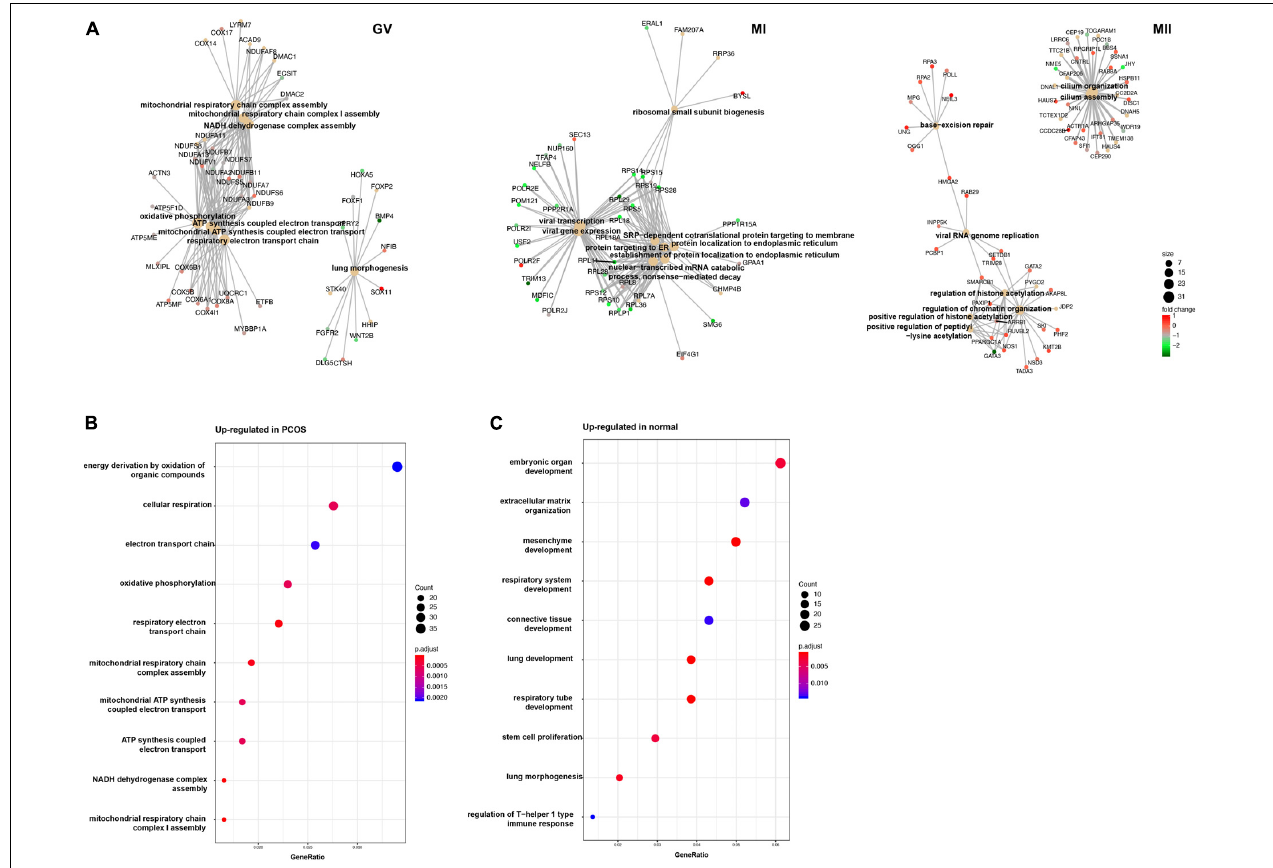
FIGURE 4 | GO analysis for DEGs in different stage. (A) Gene connect plot shows the high differential biology progress in GV (left) , MI (middle) , and MII (right) stage between healthy and PCOS oocytes. The node size represented count of genes enriched in GO terms, color represented the fold change between groups. (B) Gene ontology of up-regulated genes in PCOS oocytes at GV stage. (C) Gene ontology of down-regulated genes in PCOS oocytes at GV stage. The dot size represented the count of genes enriched in GO terms; color represented the p -value adjust of